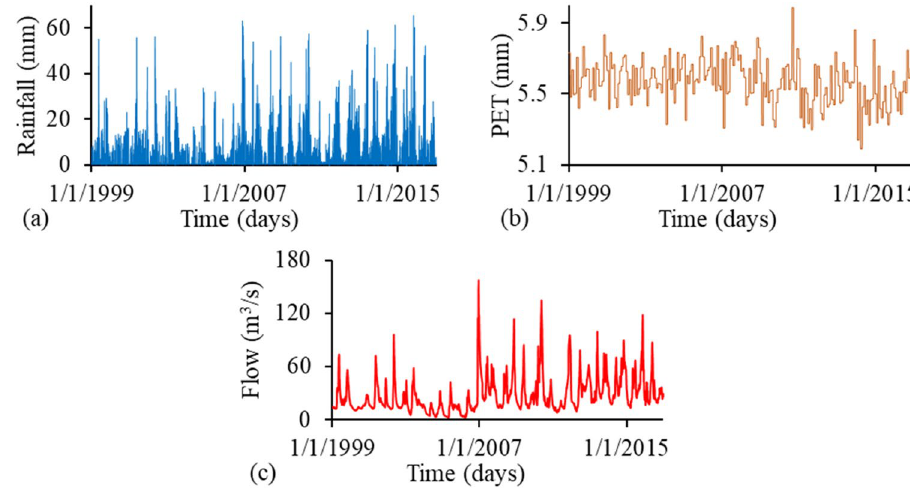
Fig. 2 Time series of a daily rainfall, b daily PET and c daily observed flow used in rainfall– runoff